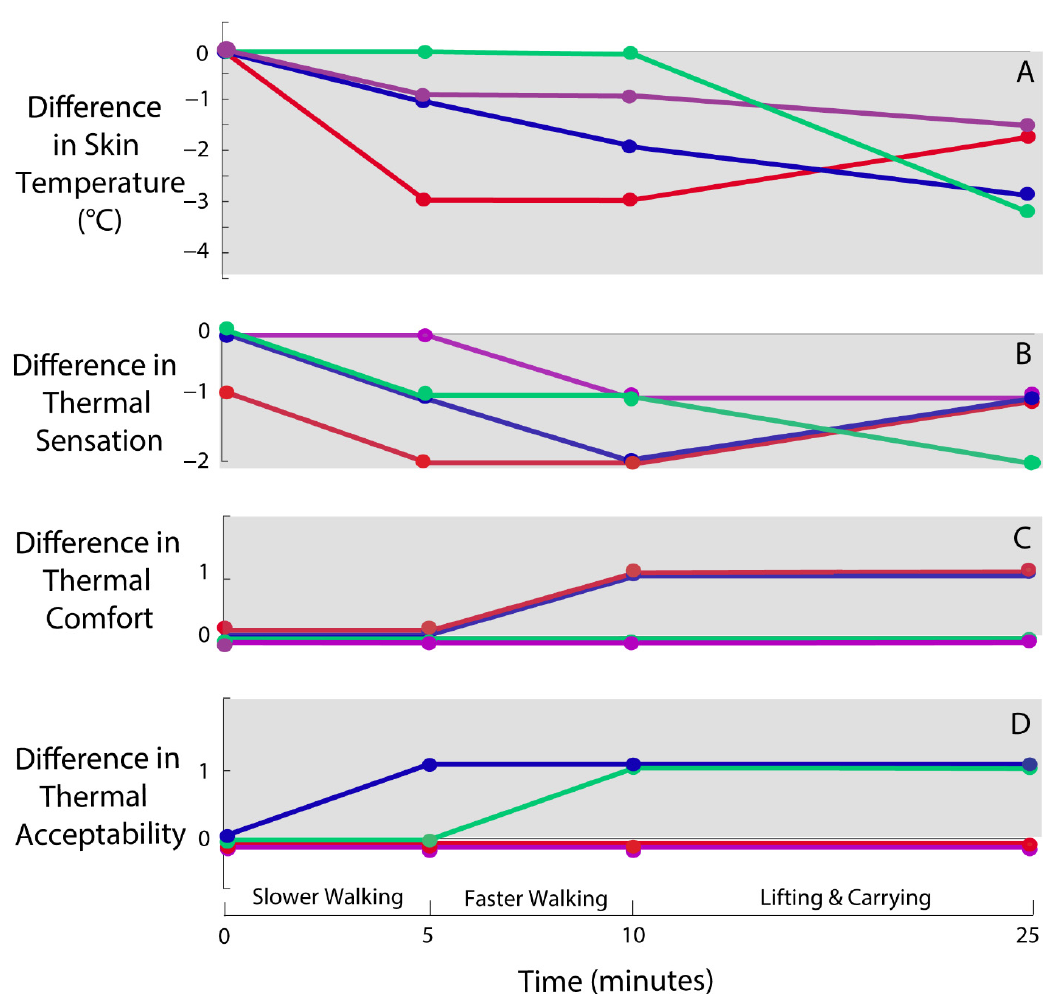
Figure 2. Differences in skin temperature and thermal ratings between Loose and Form-Fitting conditions during physical activities. Each color represents one participant. Each dot designates when in the experimental protocol a measurement was taken. Lines were added to easily visualize individual participant trends. Values on the gray background represent improvements in skin temperature ( A ), thermal sensation ( B ), thermal comfort ( C ), and thermal acceptability ( D ) for the Loose sleeve relative to the Form-Fitting sleeve. In each plot, a value of zero signifies no difference between the Loose vs. Form-Fitting sleeve.